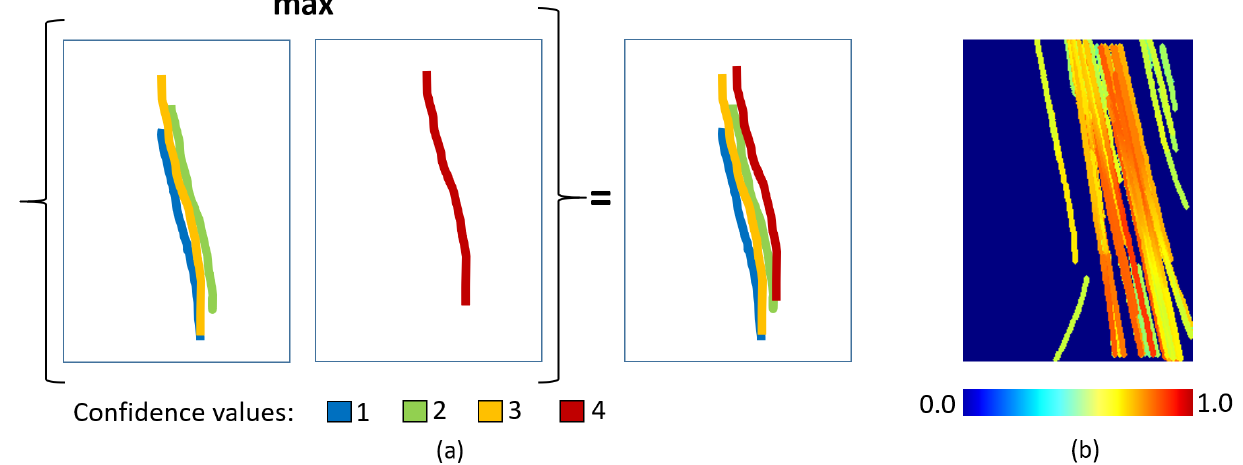
Figure 7. Creation of confidence map. Panel ( a ) shows a confidence map, which was created by overlapping traces with different confidence values. Panel ( b ) shows a confidence map generated from true vehicle tracklets, where the jet colourmap indicates confidence value from 0 (blue) to 1 (red).